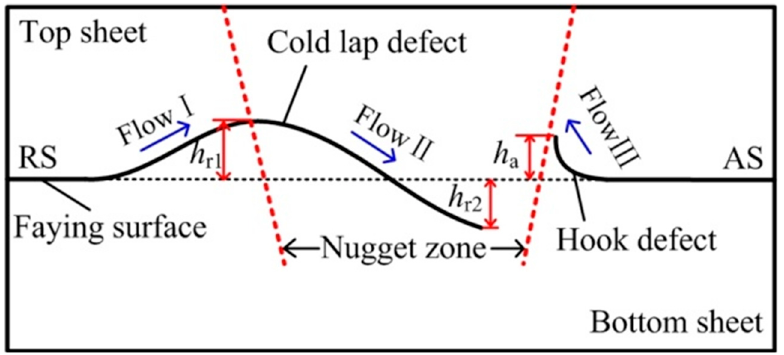
Figure 3. Schematic view of material flow during FSLW; note that the border of nugget zone is represented by the red dashed lines.